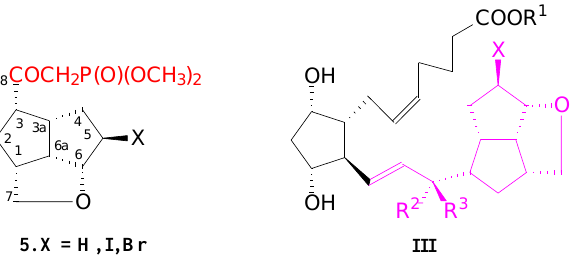
Figure 2. β -Ketophosphonates 5 ( left ) with a pentalenofurane fragment in the molecule, for obtaining new prostaglandin analogues of type III ( right ).